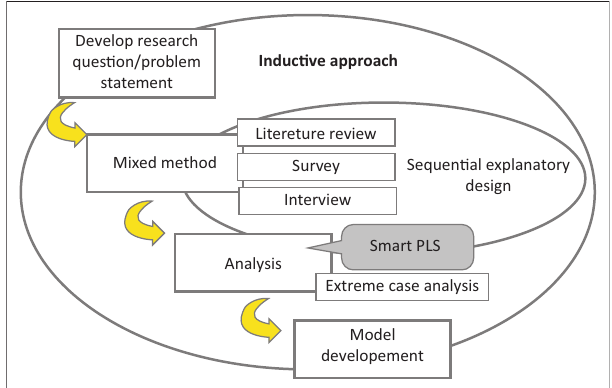
FIGURE 1: Flow of research methods and procedures.